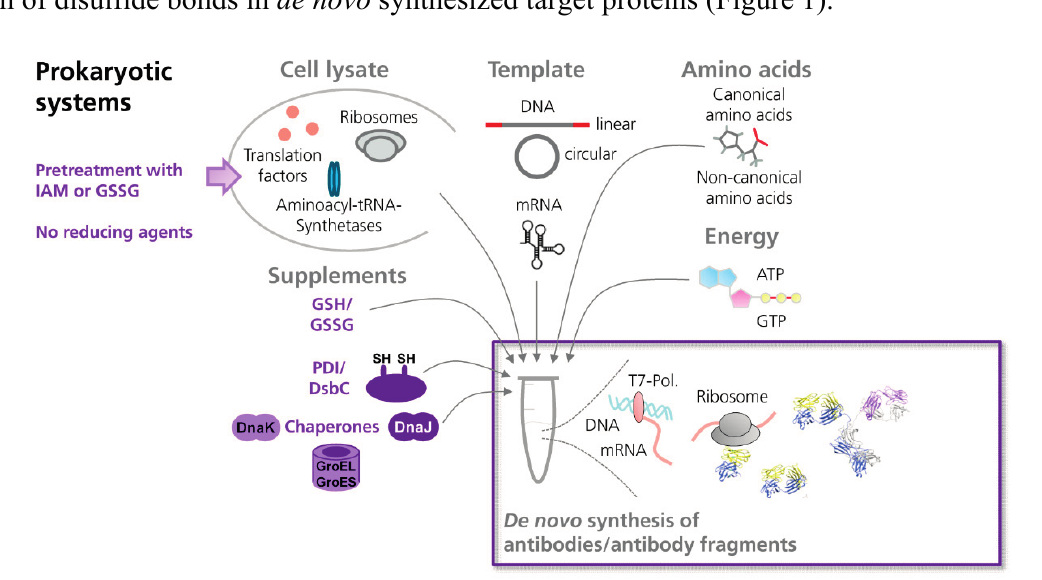
Figure 1. Scheme showing the cell-free synthesis of antibodies and antibody fragments in prokaryotic in vitro translation systems. In general, cell-extracts prepared from prokaryotic or eukaryotic cells contain the essential components necessary for translation, such as ribosomes, translation factors and enzymes. For in vitro translation, the cell lysate is supplemented with amino acids, ATP and GTP, and an energy regenerating system (e.g., creatine phosphate ⁄ creatine kinase). Synthesis of the target protein is initiated by the addition of an appropriate template either in form of DNA or mRNA. In order to allow the formation of disulfide bonds in de novo synthesized proteins, prokaryotic cell-free systems (e.g., based on E. coli ) can be supplemented with mixtures of reduced (GSH) and oxidized glutathione (GSSG), disulfide bond isomerase C (DsbC), protein disulfide isomerase (PDI) and/or chaperones (e.g., DnaK, DnaJ, GroEL, GroES). In addition, cell extracts can be pretreated with iodoacetamide (IAM) and/or defined mixtures of GSH and GSSG, in order to inactivate endogenous reductases which are present in the cell extract. (NMR structure antibody molecule, source: Protein Data Bank, 1 1IGT,